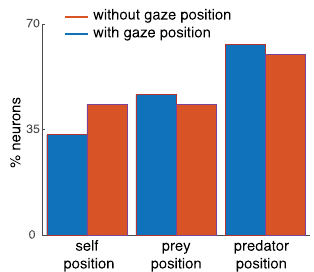
Fig. 9 Analysis to detect potential gaze confounds. Red bars: proportion of neurons tuned for three key world-centric variables using the standard GLM described above. Blue bars: same results, but this time from a version of the GLM that included eye position as a regressor. That version is constructed so that all variance possible associated with eye position is assigned to eye position fi rst and only residual encoding of task variables is counted toward those variables. All three variables are still signi fi cantly observed in the population when including gaze position. Signi fi cance was tested by two-way binomial test ( n = 10/37, p <